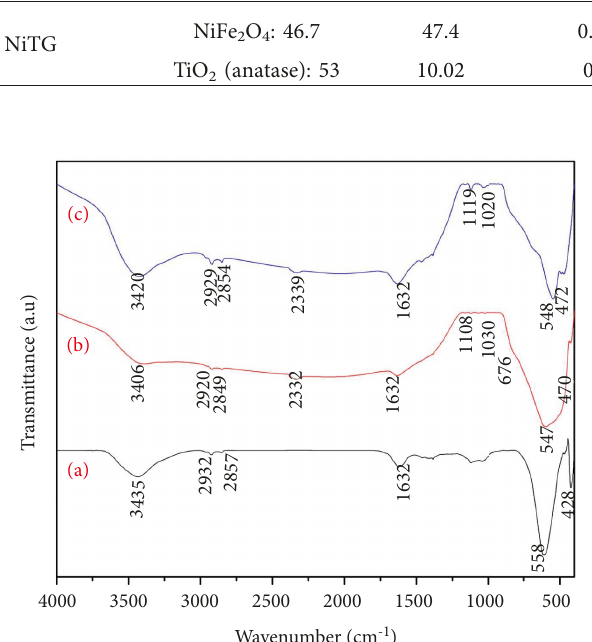
2 O 4 , (b) NiFe 2 O 4 @TiO 2 , and